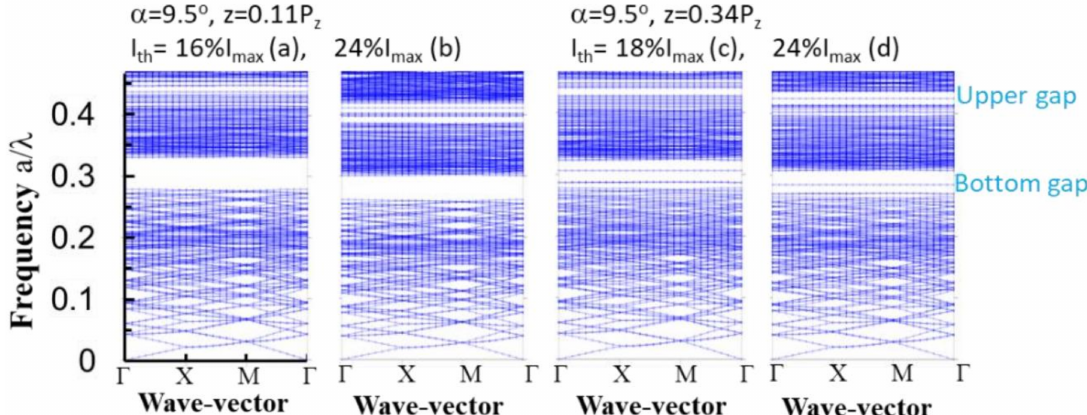
Figure 4. Photonic band structures for TE modes in moir é photonic crystal with a twist angle of 9.5 degrees at a z -location of 0.11 P z and with a threshold intensity of 16% I max ( a ) and 24% I max ( b ), and at a z -location of 0.34 P z and with a threshold intensity of 18% I max ( c ) and 24% I max ( d ).